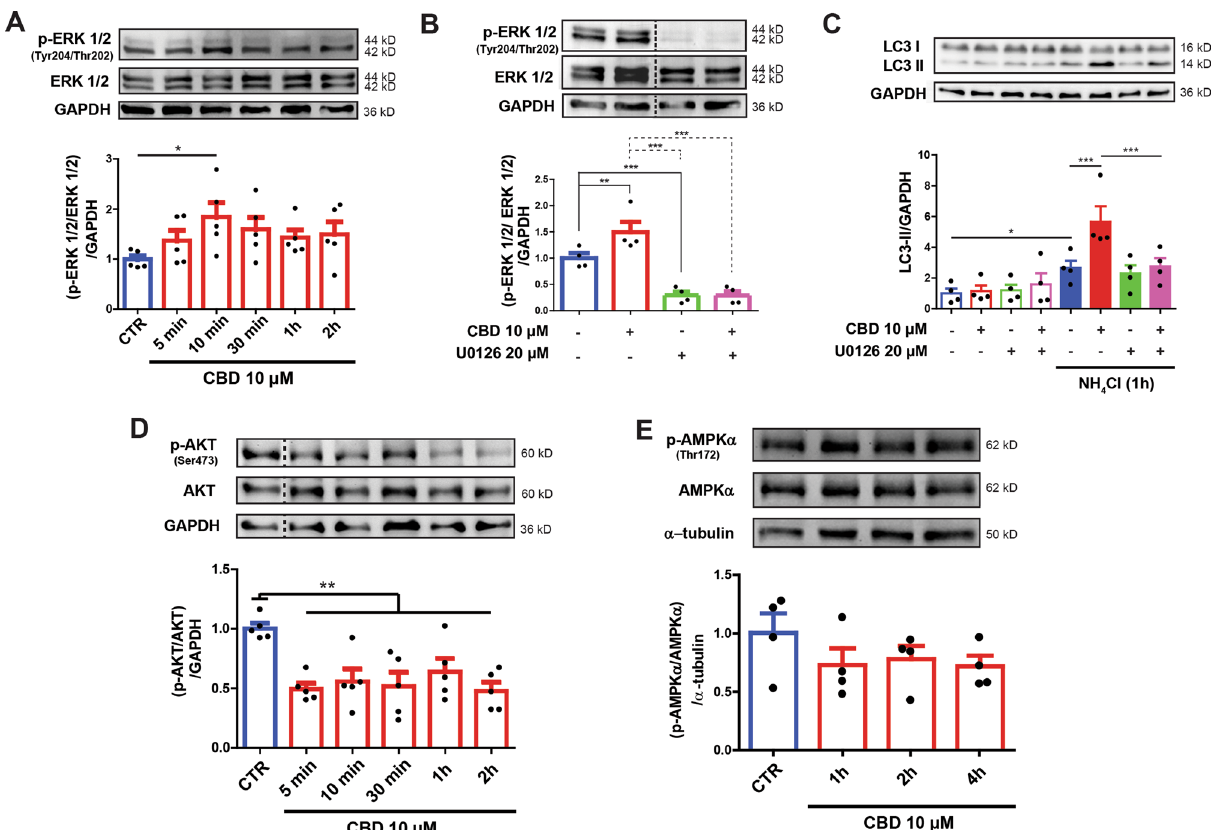
Figure 4. CBD-autophagy is mediated by ERK phosphorylation and AKT dephosphorylation. SH-SY5Y cells were treated with 10 µM CBD for 5, 10, 30 min, 1 and 2 h. ( A ) The membranes were incubated with specific antibodies directed towards phosphorylated kinase ERK1/2 (Tyr204/Thr202) or total ERK1/2 protein. Treatment with 10 µM CBD (10 µM) increased phosphorylated ERK1/2 (p-ERK) protein levels in SH-SY5Y cells after 10 min. ( B ) Cells pre-treated with 20 µM of the ERK1/2 inhibitor U0126 for 30 min and then exposed to 10 µM CBD for 10 min did not exhibit increased levels of phosphorylated ERK1/2 (p-ERK) protein in SH-SY5Y cells. ( C ) Cells were pre-treated with 20 µM U0126 for 30 min and then exposed to 10 µM CBD for up to 2 h, in the presence or absence of the lysosome inhibitor NH 4 Cl, at the last hour of the treatment. The 10 µM CBD treatment increased LC3-II levels under NH 4 Cl treatment, which was reverted with U0126 treatment. ( D ) Total cell lysates from SH-SY5Y cells treated with 10 µM CBD for 5, 10, 30 min, 1 and 2 h. Immunoblots were incubated with a specific antibody for phosphorylated AKT (Ser473) or with an antibody that recognizes total AKT and an antibody against GAPDH. CBD decreased the levels of phosphorylated AKT protein in the SH-SY5Y cells. ( E ) Cells were treated with 10 µM CBD for 1, 2 and 4 h, and the blots were incubated with a specific antibody for phosphorylated AMPK (Thr172) or with an antibody that recognizes total AMPK and an antibody directed against α-tubulin. No effect on AMPK phosphorylation (Thr172) was observed. Analysis was conducted with one, two, or three-way ANOVA followed by Sidak’s post-hoc test; * p < 0.05, ** p < 0.01 and *** p < 0.001. Full-length blots are presented in Supplementary Figure S3 and